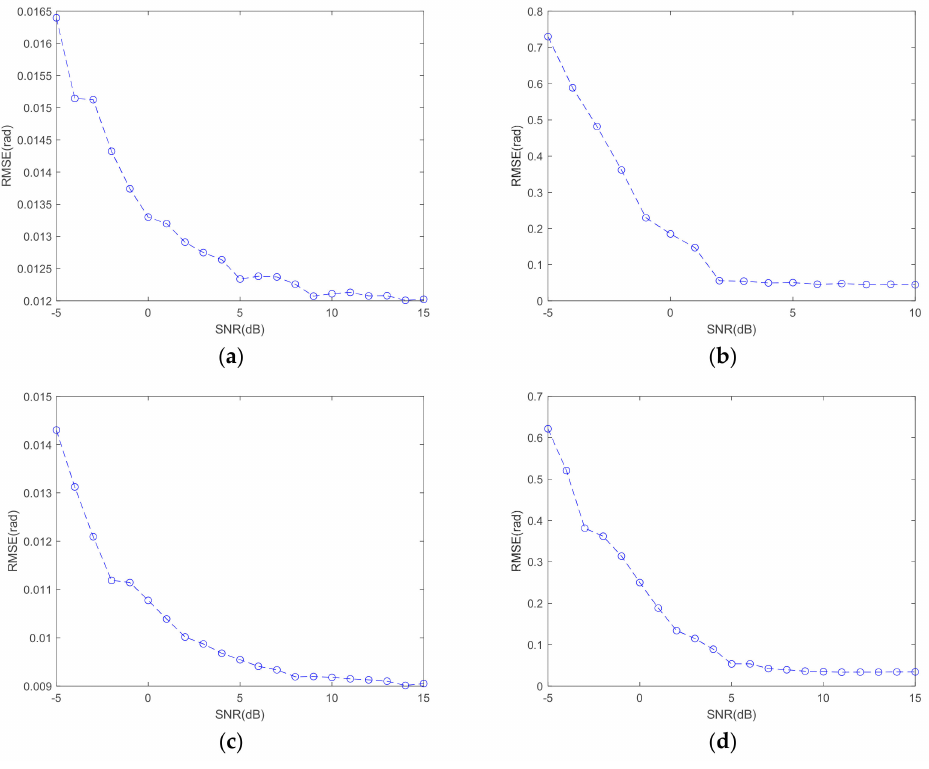
Figure 21. The RMSE of the estimated vibration phase values with different SNRs: ( a ) Under condition 1; ( b ) under condition 2; ( c ) under condition 3; ( d ) under condition